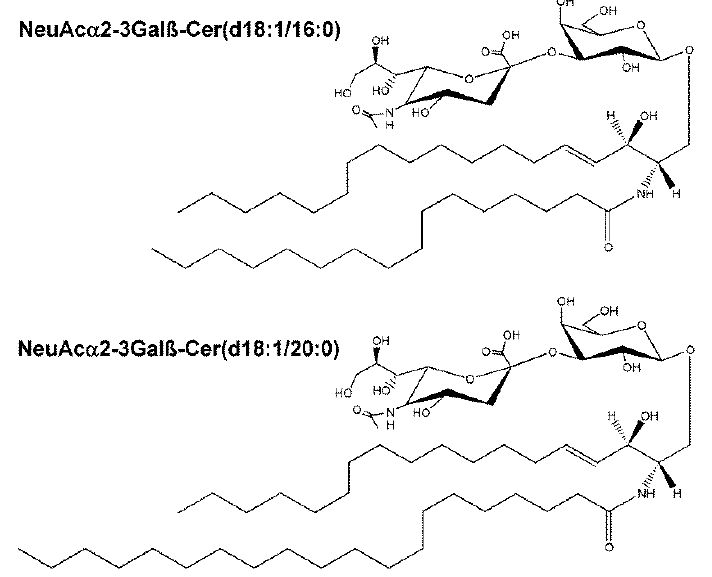
Figure 4. Two galactoceramides diminished in plasma of HCV-positive